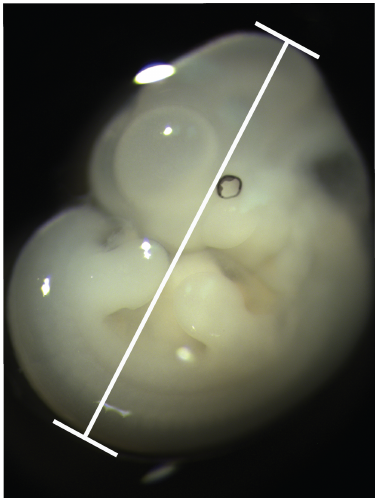
Figure 1. Crown-rump length measures the maximum total length of an embryo using a sagittal